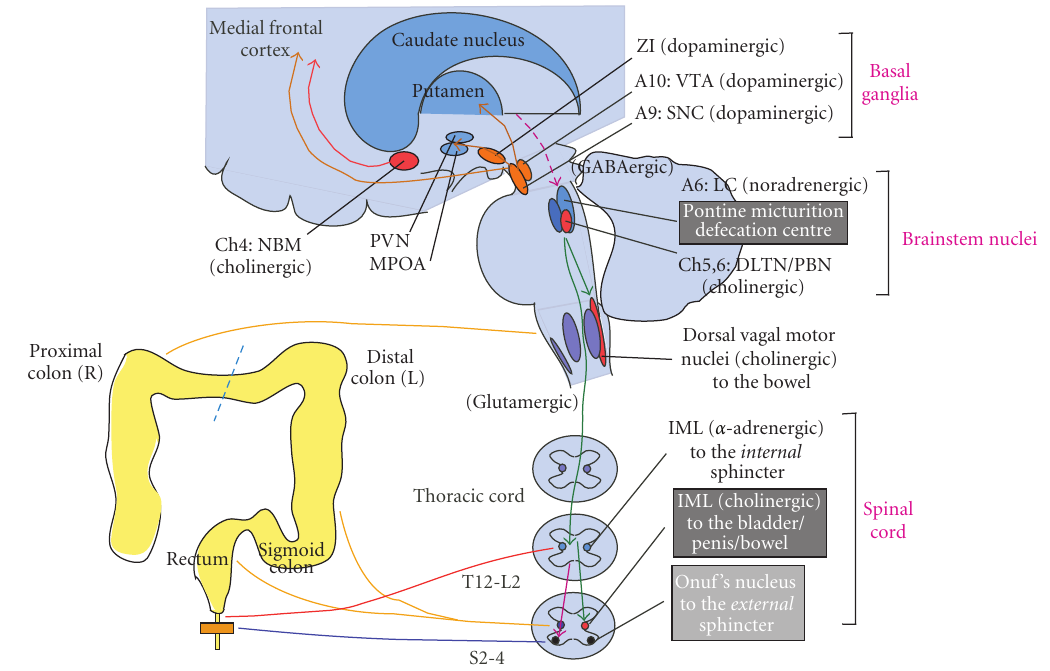
Figure 5: Neural circuitry relevant to defecation. Although less significantly than the lower urinary tract (LUT) does, it is thought that function of the lower gastrointestinal tract depends on the brain and the spinal cord. Whereas small intestine and ascending colon are innervated by the vagus nerves originating in the medulla, descending colon, sigmoid colon, and rectum primarily share sacral innervation of the LUT (Figure 1). Both the sacral cord and the vagus nuclei receive projecting fibers from Barrington’s nucleus (the pontine micturition/defecation center). Bowel function seems to be modulated by the higher brain structures; including the frontal lobe, the hypothalamus, and the basal ganglia; the main action of the latter on the bowel seems to be inhibitory. NBM: nucleus basalis Meynert, Ch: cholinergic, PVN: paraventricular nucleus, MPOA: medial preoptic area, ZI: zona incerta, A: adrenergic/noradrenergic, VTA: ventral tegmental area, SNC: substantia nigra pars compacta, LC: locus ceruleus, DLTN: dorsolateral tegmental nucleus, PBN: parabrachial